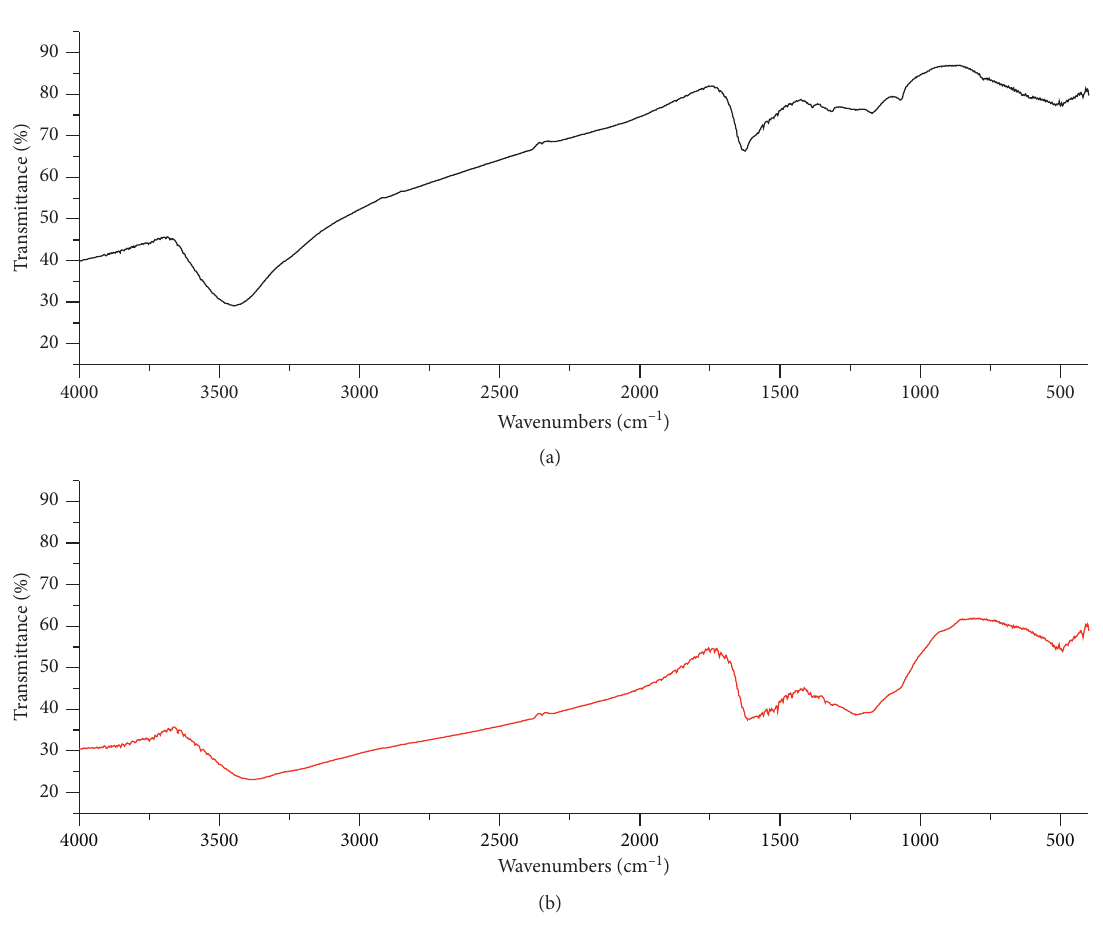
Figure 1: FTIR analysis of CISAC before (a) and after (b) Pb (II) ion adsorption.